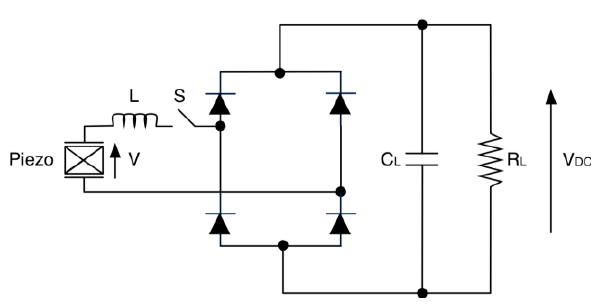
Figure 32. Series-SSHI configuration.